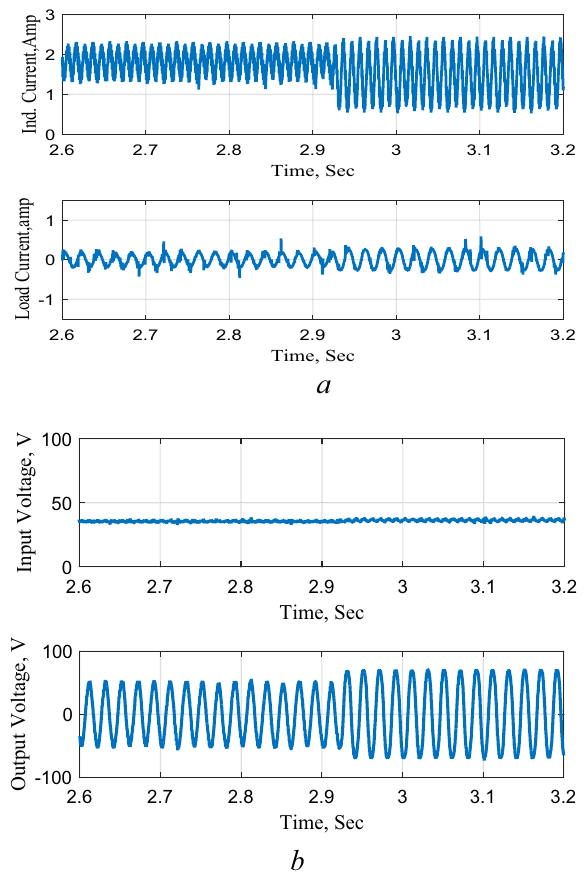
Figure 17. Response to a step change in the reference voltage. ( a ) Inductor and output currents, ( b ) input and output